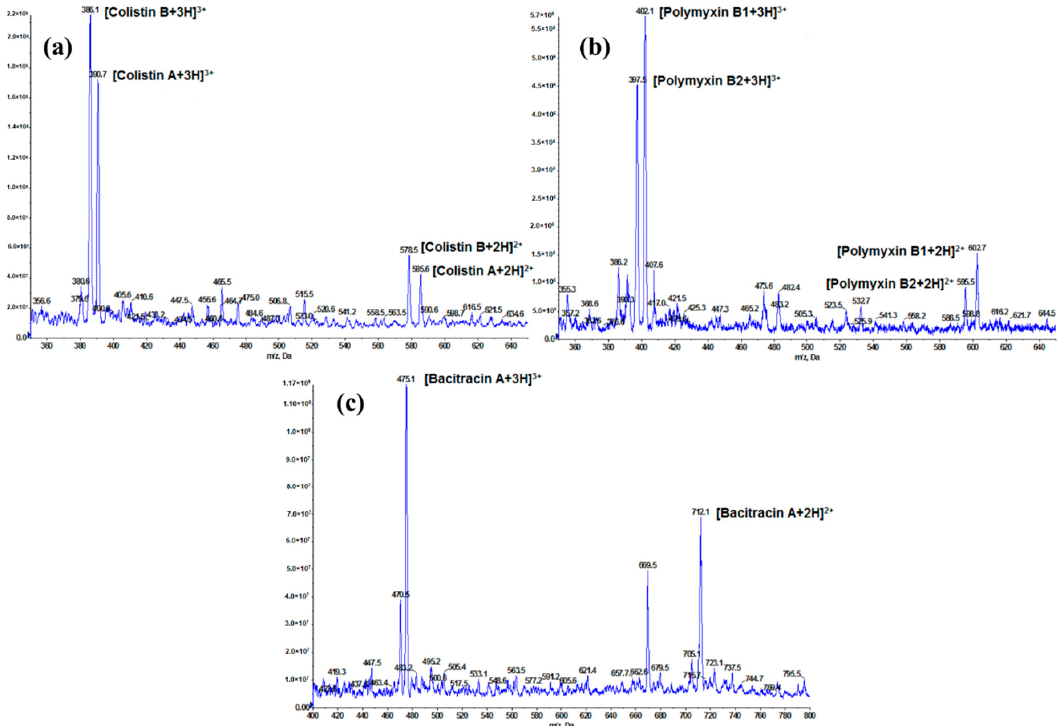
Figure 2. Mass spectrum of polypeptide antibiotic in which doubly and triply charged ions of colistin A and B ( a ); polymyxin B1 and B2 ( b ); and bacitracin A ( c ) can be seen.